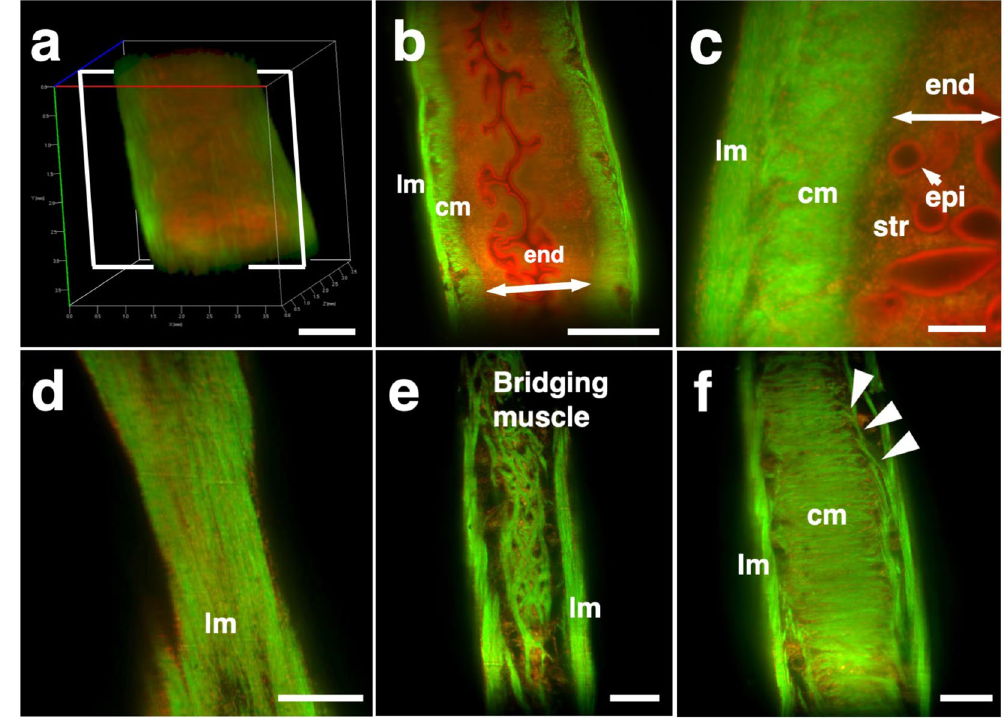
Figure 2. Three-dimensional and cross-sectional images of the EGFP-positive mouse uterus. Female CAG- EGFP transgenic mice were transcardially perfused with 4% PFA containing PI. After the isolated uterus was subjected to CUBIC, 3D and cross-sectional images were taken by light-sheet microscopy. ( a ) A 3D image of EGFP and PI signals of the uterus. ( b ) A sectional image within the white square of ( a ). ( c ) A highly magnified image of ( b ). ( d – f ) Reconstructed sequential coronal image of the myometrium showed an outer layer ( d ), middle layer ( e ), and inner layer ( f ). Note that EGFP fluorescence of the muscle fibers was high in the myometrium, but very low in the endometrium. A mesh-like structure of muscle fibers that connected the longitudinal and circumferential myometrium was observed in the middle muscle layer (arrowhead). lm, longitudinal muscle layer; cm, circumferential muscle layer; end, endometrium; str, stromal cells; epi, epithelial cells. Scale bars, 1 mm ( a , b ), 200 µ m ( c ), and 500 µ m ( d–f